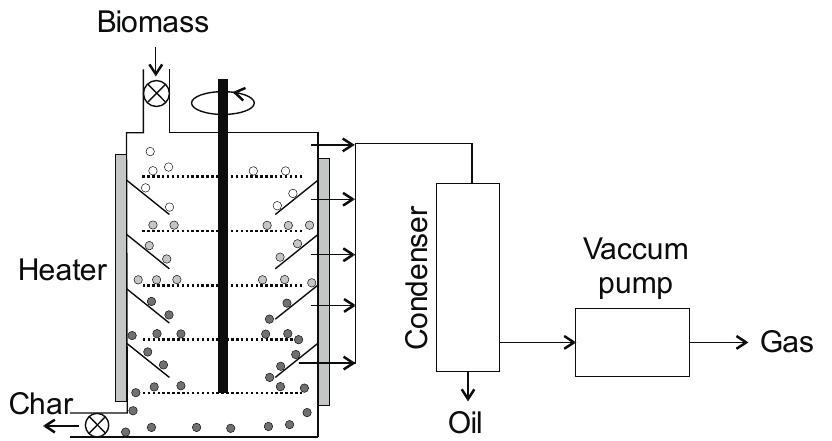
Figure 11. Entrained flow vacuum reactor (adopted from [136]).